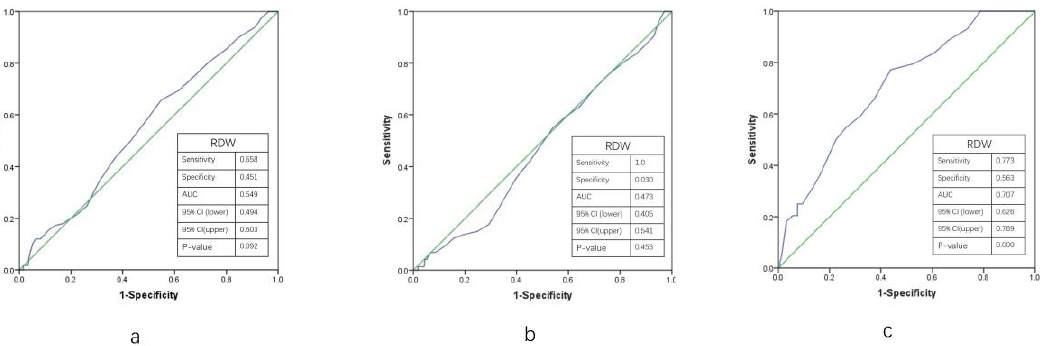
Figure 2. The ROC curve of RDW for predicting no-reflow phenomenon in all patients ( a ), No-DM patients ( b ), and DM patients ( c ). Green lines: diagonal reference line; Blue lines: ROC curve. ROC: receiver-operating characteristics; RDW: red cell distribution width; DM: diabetes mellitus; AUC: area under curve; CI: confidential interval).